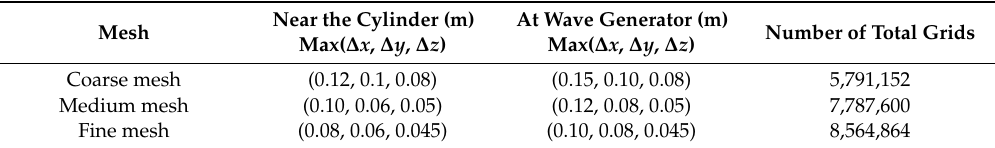
Table 2. The resolutions of three di ff erent